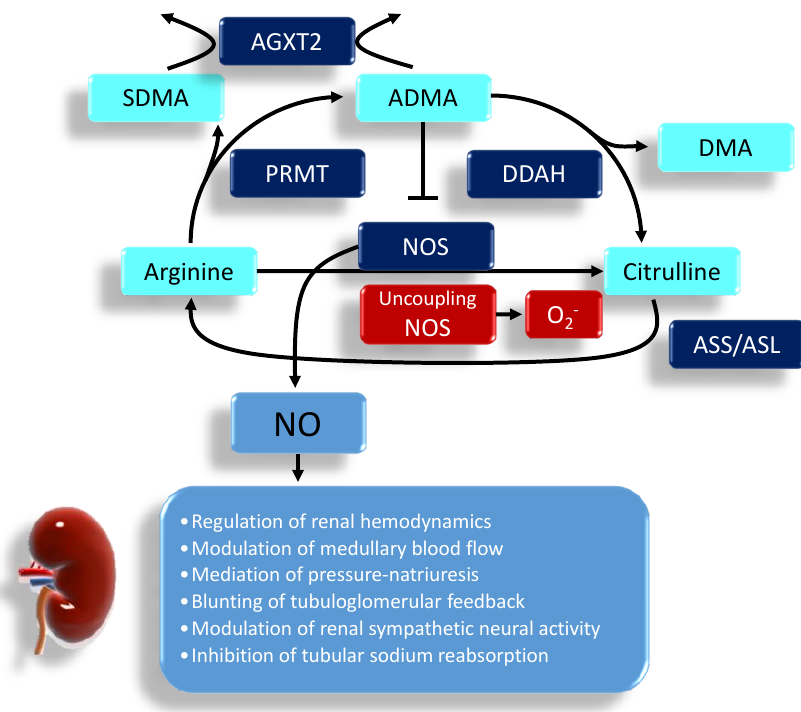
Figure 1. The regulation of the NO system in the kidney. L -arginine has multiple metabolic fates, including metabolism by NOS, arginase, and other enzymes. ADMA is capable of competing with L -arginine to inhibit NO production. Both ADMA and symmetric dimethylarginine (SDMA) come from the methylated L -arginine by protein arginine methyltransferase isoenzyme family (PRMT). Unlike SDMA, only ADMA can be metabolized by dimethylarginine dimethylaminohydrolase (DDAH)-1 and -2 to generate L -citrulline and dimethylamine (DMA). Alanine-glyoxylate aminotransferase 2 (AGXT2) can metabolize ADMA as well as SDMA. On the other hand, L -citrulline can be converted to L -arginine via the argininosuccinate synthetase (ASS) and argininosuccinate lyase (ASL). ADMA can uncouple NOS to produce superoxide. In the kidney, NO is responsible for many physiological functions. The arrow means produces, indicating result of reaction. The T-bar means inhibits.